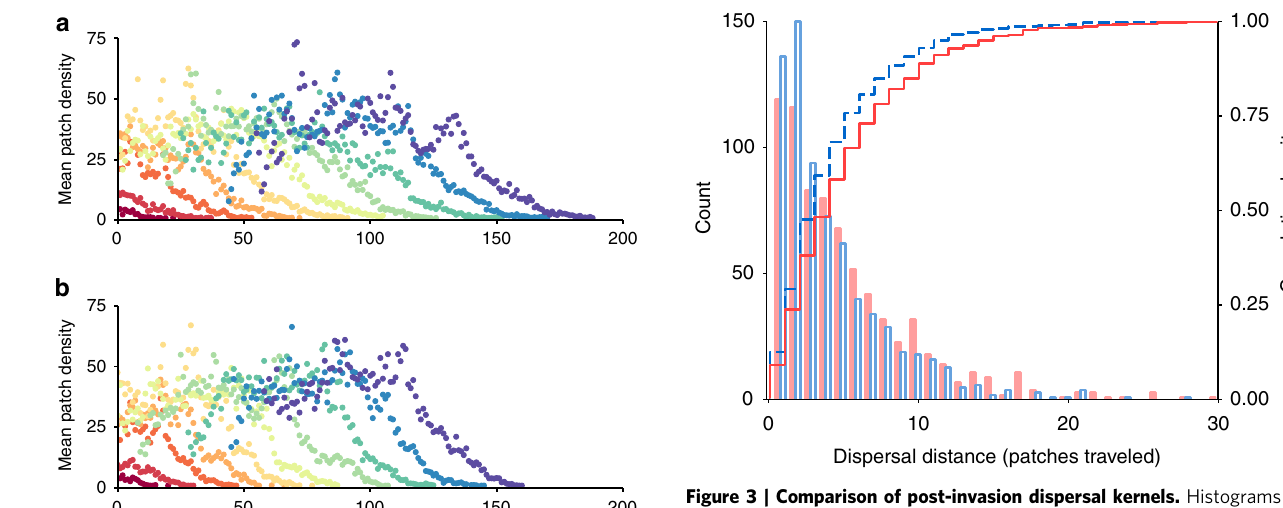
Figure 3 | Comparison of post-invasion dispersal kernels. Histograms (left axis) show dispersal distances of beetles descended from spatially sorted (filled red bars) and shuffled (open blue bars) invasions following one generation in a common environment; results from a second generation in a common environment were qualitatively similar (Supplementary Figs 4 and 5). Lines show corresponding empirical cumulative distribution functions (right axis; sorted: red solid line; shuffled: blue dashed line). Beetles from spatially sorted invasions dispersed farther on average than beetles from shuffled invasions ( N ¼ 3,240, D þ ¼ 0.0646, P oo 0.0001). A hierarchical Bayesian analysis that accounted for random variance across replicates and fitted male and female kernels separately yielded similar results (Methods, Supplementary Tables 4 and